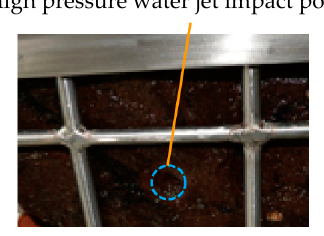
Figure 13. The oil shale sample produces a broken pit on the surface of the vertical bedding.